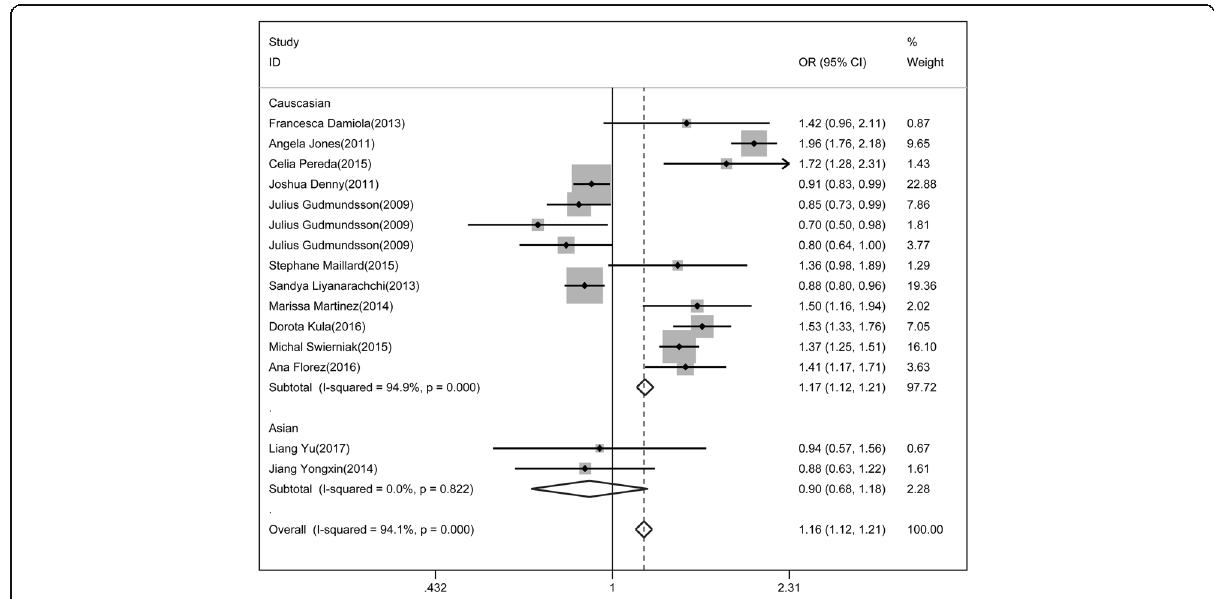
Fig. 2 Association of rs965513 polymorphism with differentiated thyroid cancer